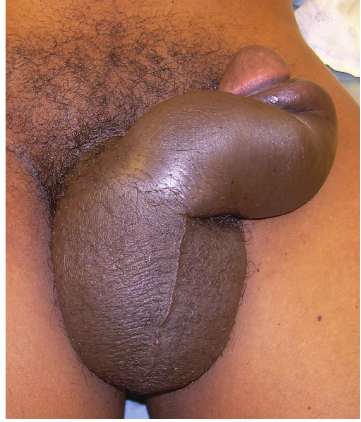
Figure 3: Cavernosal repair.